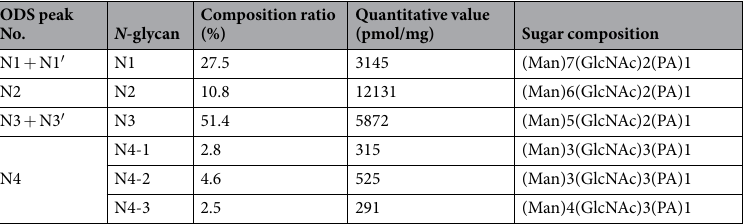
Table 1. Compositions and quantitative values of the identified N